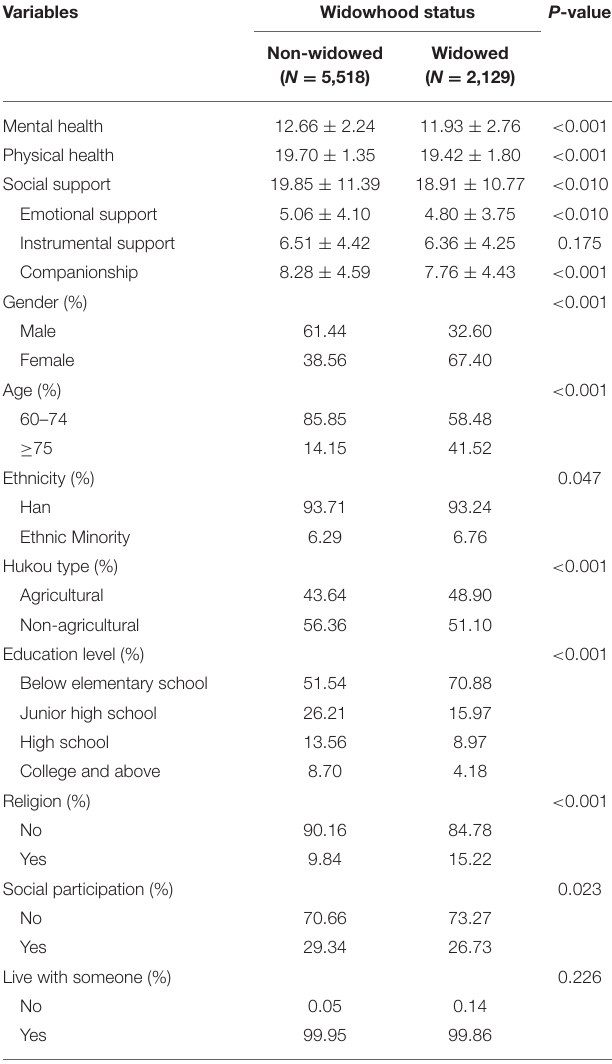
TABLE 1 | Descriptive statistics for widowed vs. non-widowed participants ( N =